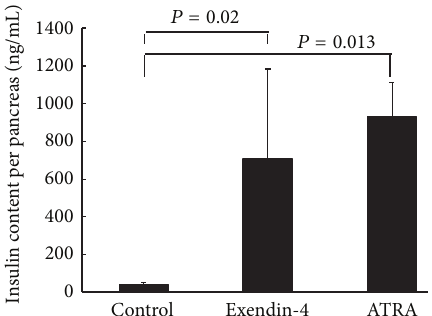
Figure 3: The pancreatic insulin content in adoptive transferred NOD/scid mice treated with vehicle, ATRA, and exendin-4.